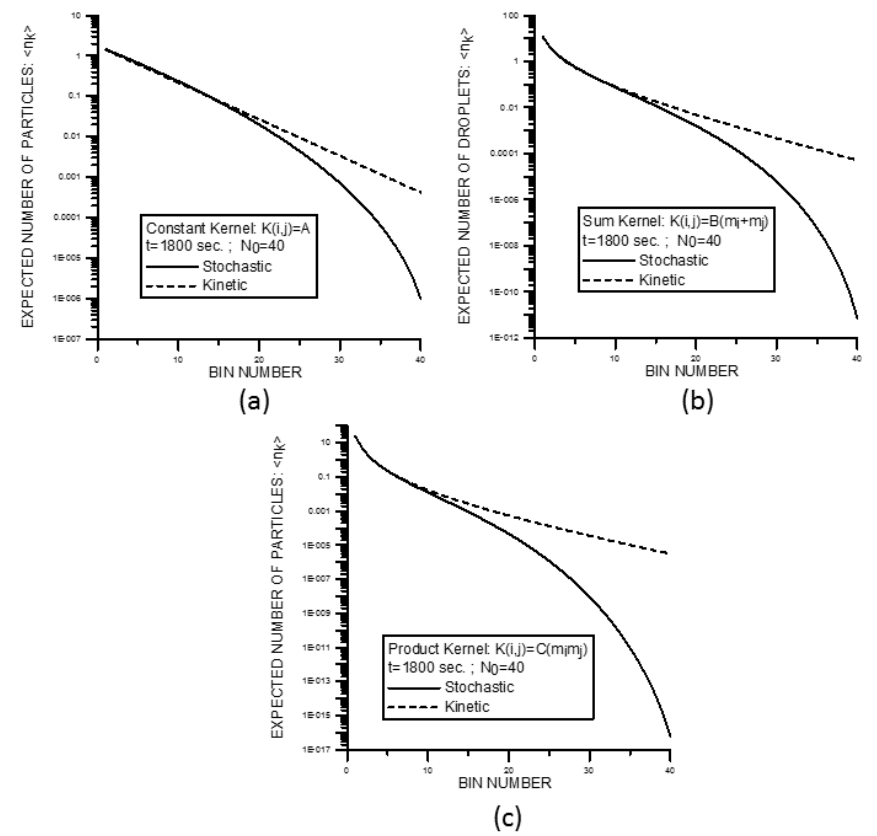
Figure 7. Comparison of the size distributions obtained from the stochastic master equation (solid line) with that of the KCE (dashed line) at t = 1800s for a 1cm 3 system containing initially 40 droplets of 14µm. The expectation values are shown for the constant, sum and product kernels (in panels a , b and c , respectively). For the small end the size distributions are closely coincident, for the large end the two equations give different values.